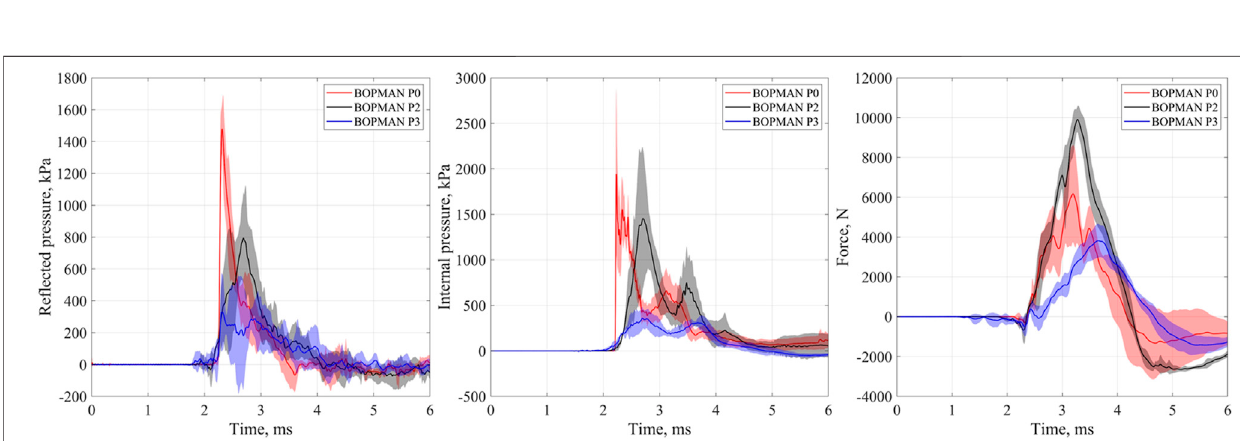
FIGURE 6 | Illustration of BOPMAN measurement for the three levels of protection: unprotected (P0, red line); soft ballistic pack (P2, black line) and hard ballistic pack(P3,blueline).Timehistoriesofthere fl ectedpressure(Left),theinternalpressure(middle),andtheforce(Right).Solidlinerepresentsthemeantimehistory,whereas the shaded area corresponds to the standard